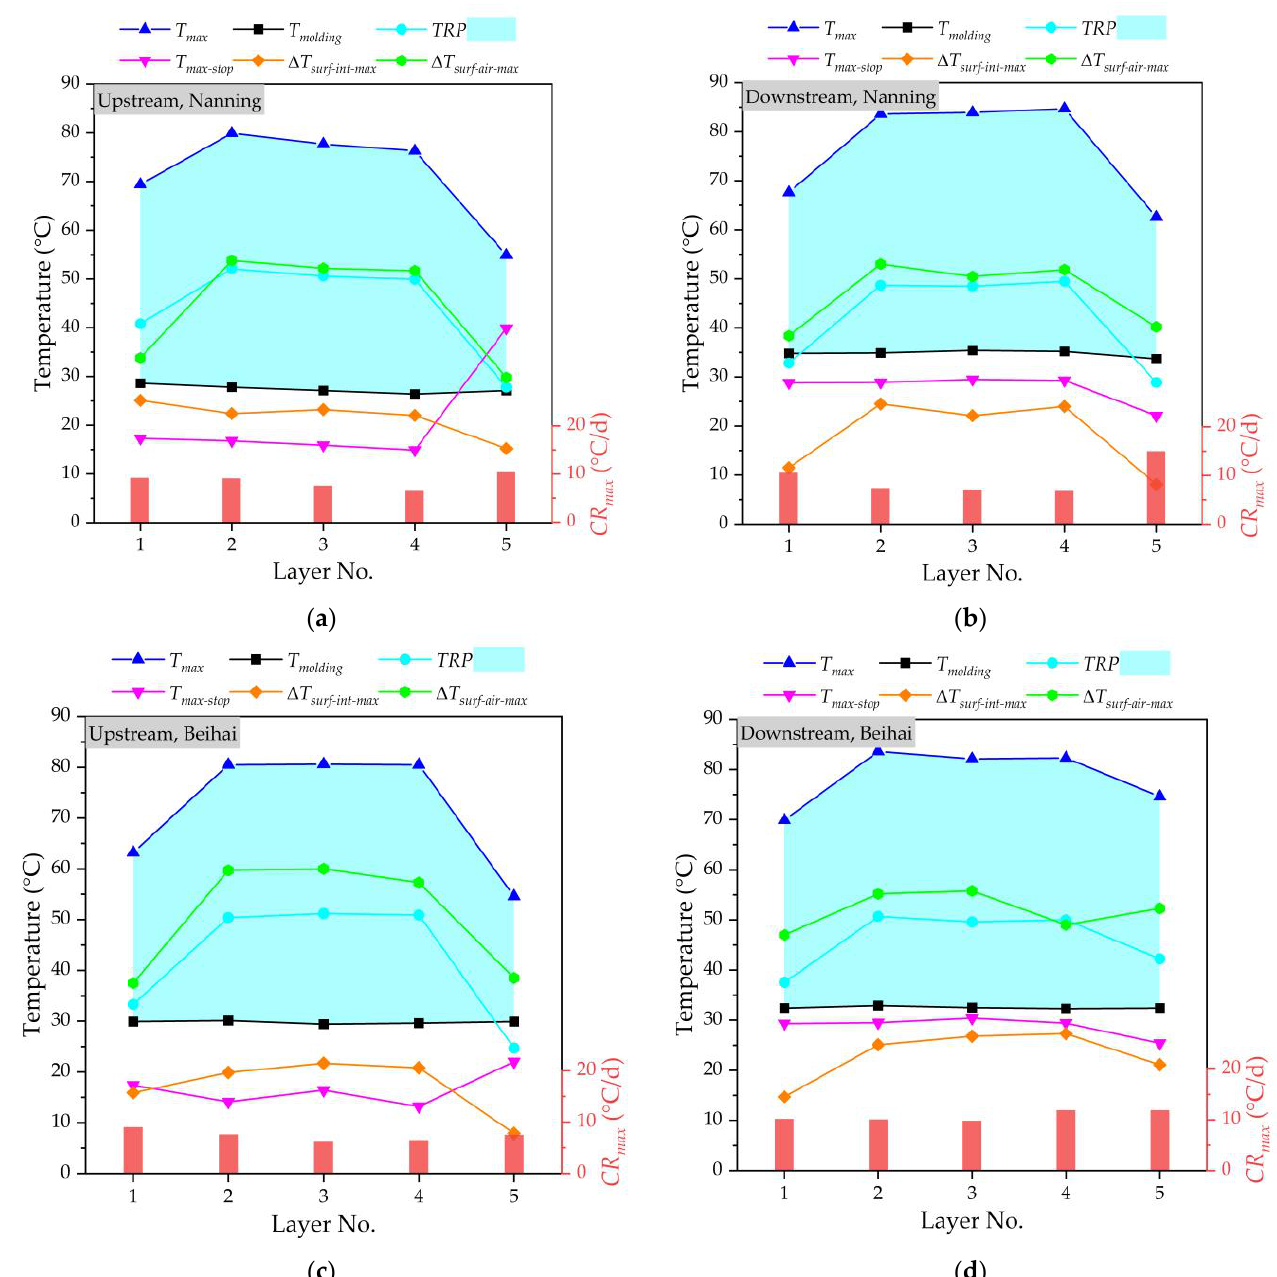
Figure 8. Temperature monitoring of mass concrete in lower main pier: ( a ) at the upstream of Nanning side; ( b ) at the downstream of Nanning side; ( c ) at the upstream of Beihai side; ( d ) at the downstream of Beihai side.